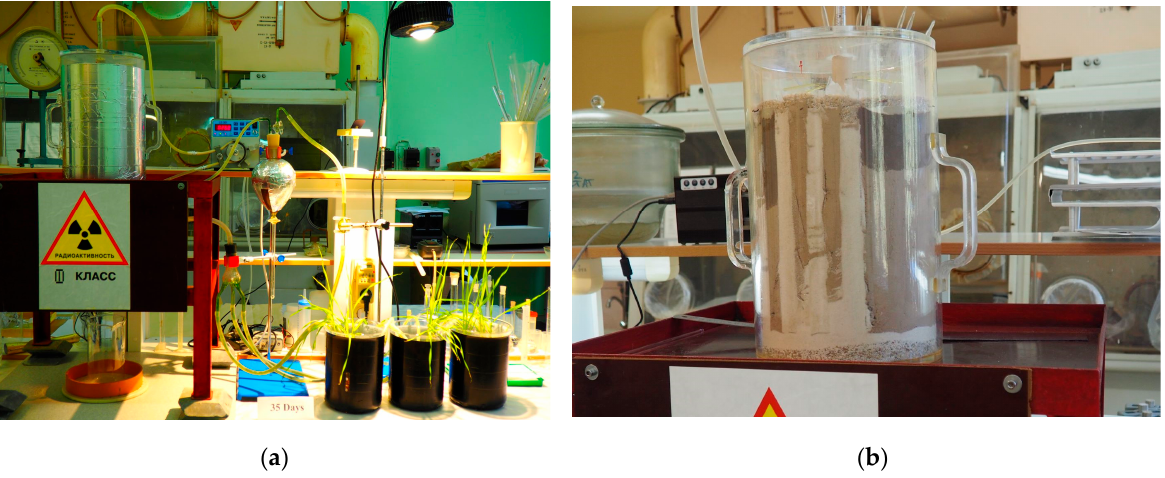
Figure 2. Experimental setup for studying Cd/ 109 Cd migration parameters in the soil–lysimeter solution–plant system: ( a ) vegetation stand assembly; ( b ) lysimeter setup.